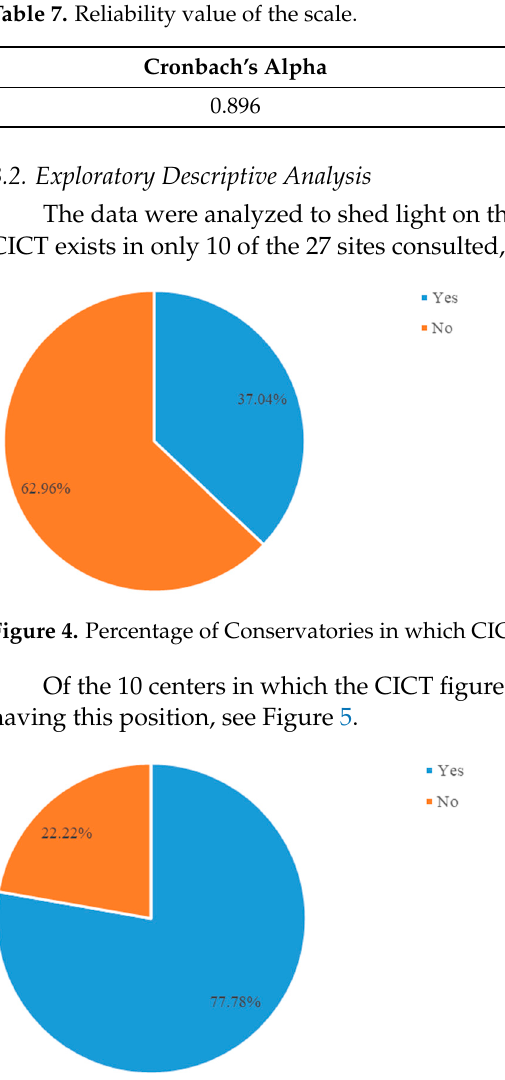
Figure 5. Percentage of CICT that have a time discount for the charge .